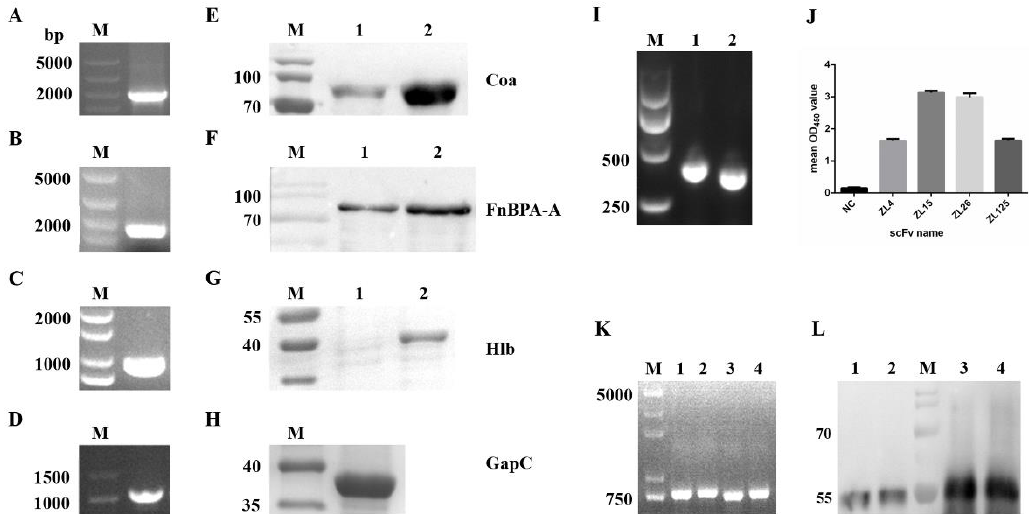
Figure 1. PCR products and protein purification of scFvs and virulence factors of S. aureus. PCR amplification products of coa ( A ), fnbpA-A ( B ), hlb ( C ) and gapC ( D ). Lane M of ( A – D , I , K ), DNA ladder. Western blotting assay of Coa ( E ) and FnBPA-A ( F ), SDS–PAGE analysis of Hlb ( G ), GapC ( H ). Lane M of ( E – H , L ), protein molecular weight marker; lane 1–2 of ( E ), purified Coa protein eluted by 100 mM imidazole and 150 mM imidazole, respectively; lane 1–2 of ( F ), the purified FnBPA-A protein eluted by 50 mM imidazole and 100 mM imidazole, respectively; lane 1 of ( G ), protein of Hlb without IPTG induction; lane 2 of ( G ), purified Hlb protein eluted by 100 mM imidazole. ( I ), PCR products of VH and VL. Lane 1, PCR products of VH; Lane 2, PCR products of VL. ( J ), Affinity analysis of different scFvs. ( K ), PCR products of scFv amplificated from positive scFv phage clones. lane 1–4, scFv PCR products of ZL4, ZL15, ZL26 and ZL125, respectively. ( L ), Western blotting analysis of four purified scFv products. lane 1–4, purified scFv products of ZL4, ZL26, ZL15 and ZL125, respectively.